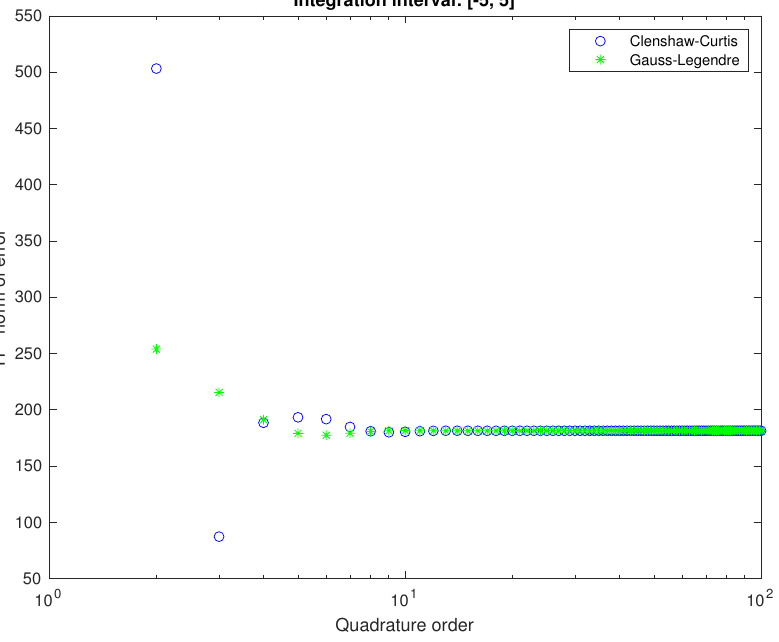
Figure 8. Analysis of (cid:107) e (cid:107) ∞ norm with increasing order of quadrature for the integration interval of [ − 5,5 ] . Isolated low error is an artifact of phase oscillation.